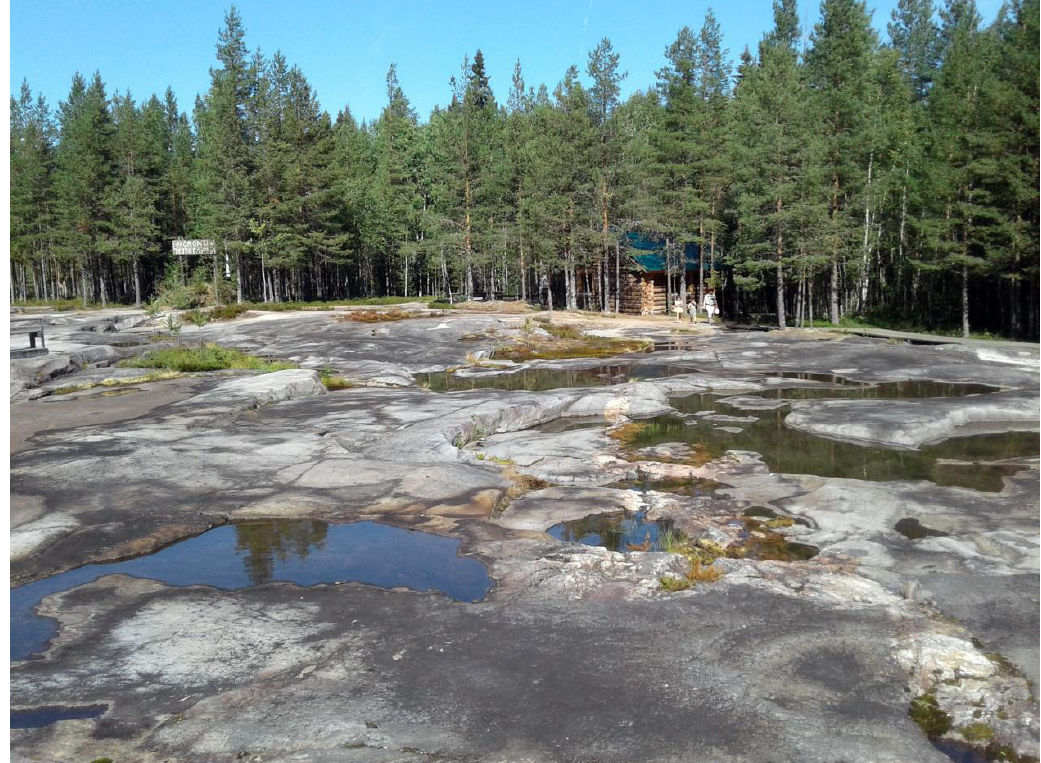
Fig. 1. Karelia, Belomorsk environment, Vygostrov, former riverbed of Vyg River, habitat of Hydrophorus signifer